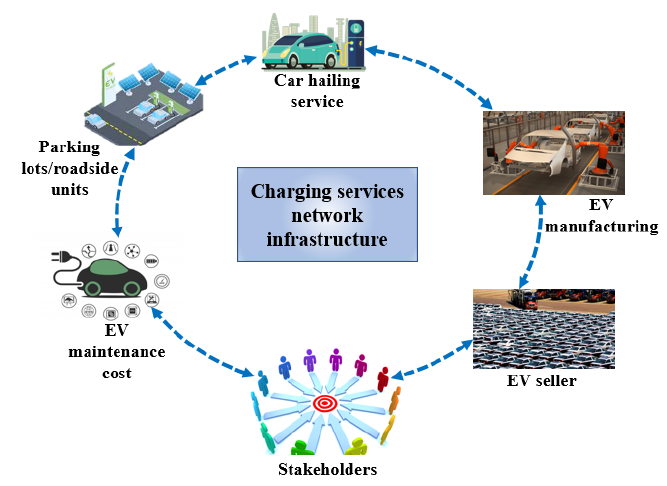
Figure 3. Charging service networks’ operation modes.